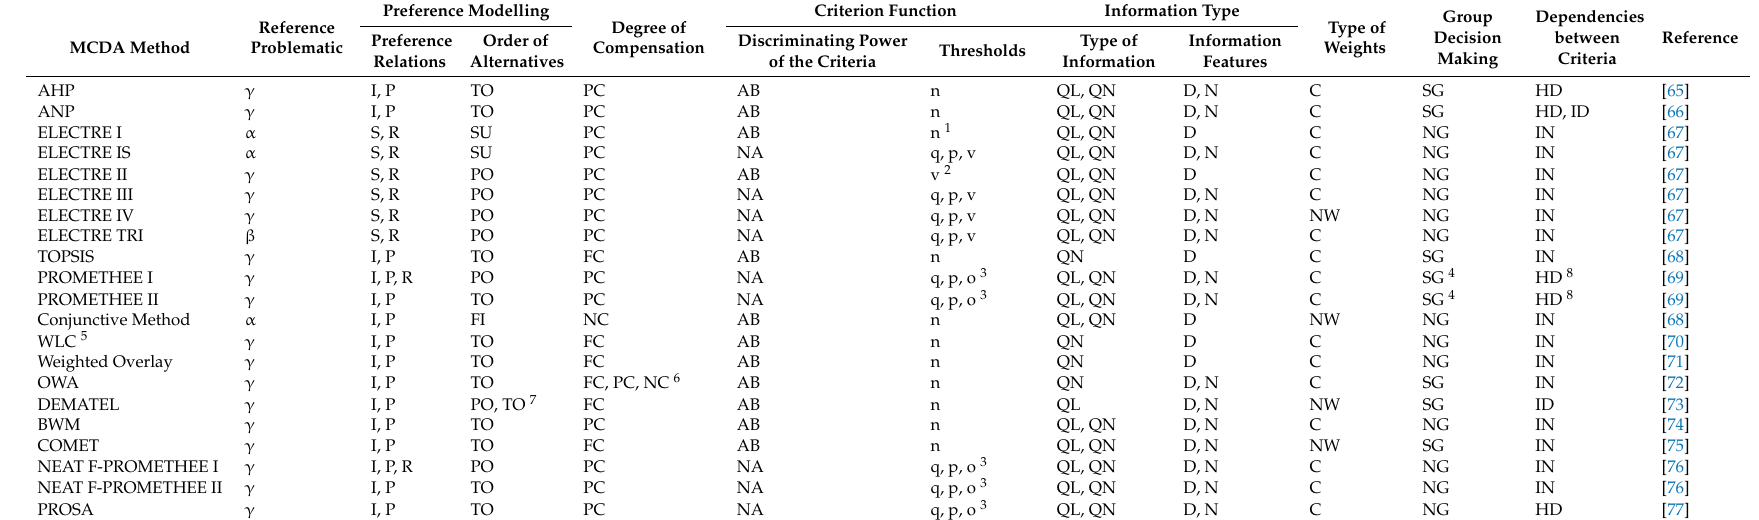
Table 3. Characteristics of MCDA methods applied in the field of wind energy.